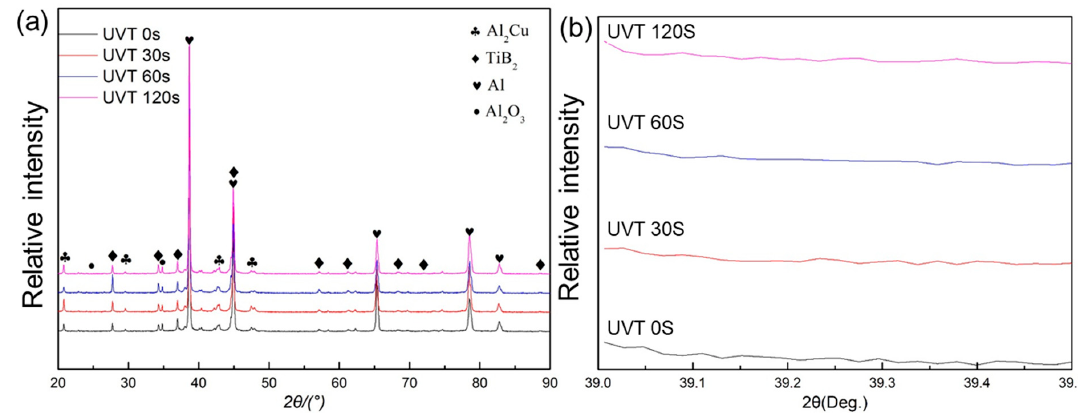
Figure 2. X ‐ ray diffraction (XRD) pattern of TiB 2 /2A14 composites: ( a ) diffraction angle from 20° to Figure 2. X-ray di ff raction (XRD) pattern of TiB 2 / 2A14 composites: ( a ) di ff raction angle from 20 ◦ to 90 ◦ ; 90°; ( b ) diffraction angle from 39.0°to 39.5°. ( b ) di ff raction angle from 39.0 ◦ to 39.5 ◦